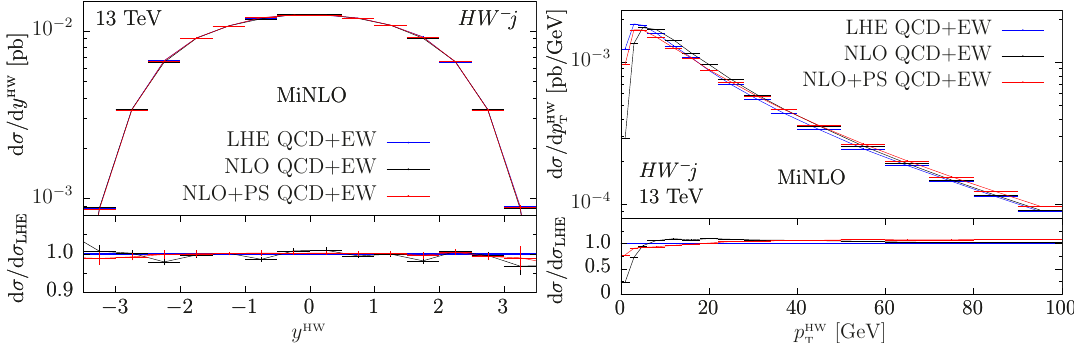
Figure 18. Distributions in the rapidity (left) and transverse momentum (right) of the recon- structed HW (cid:0) pair. Improved MiNLO results for pp HVj at NLO QCD+EW are compared ! at (cid:12)xed order, at the level of Les Houches events (LHE), and including also the full QCD+QED parton shower of Pythia 8.1 (NLO+PS). In the ratio plot results are normalized with respect to the LHE level prediction.